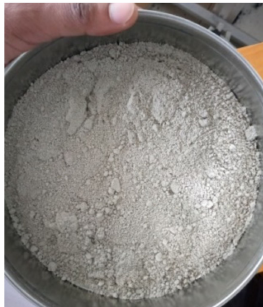
Figure 1. The NSHA used for this study.